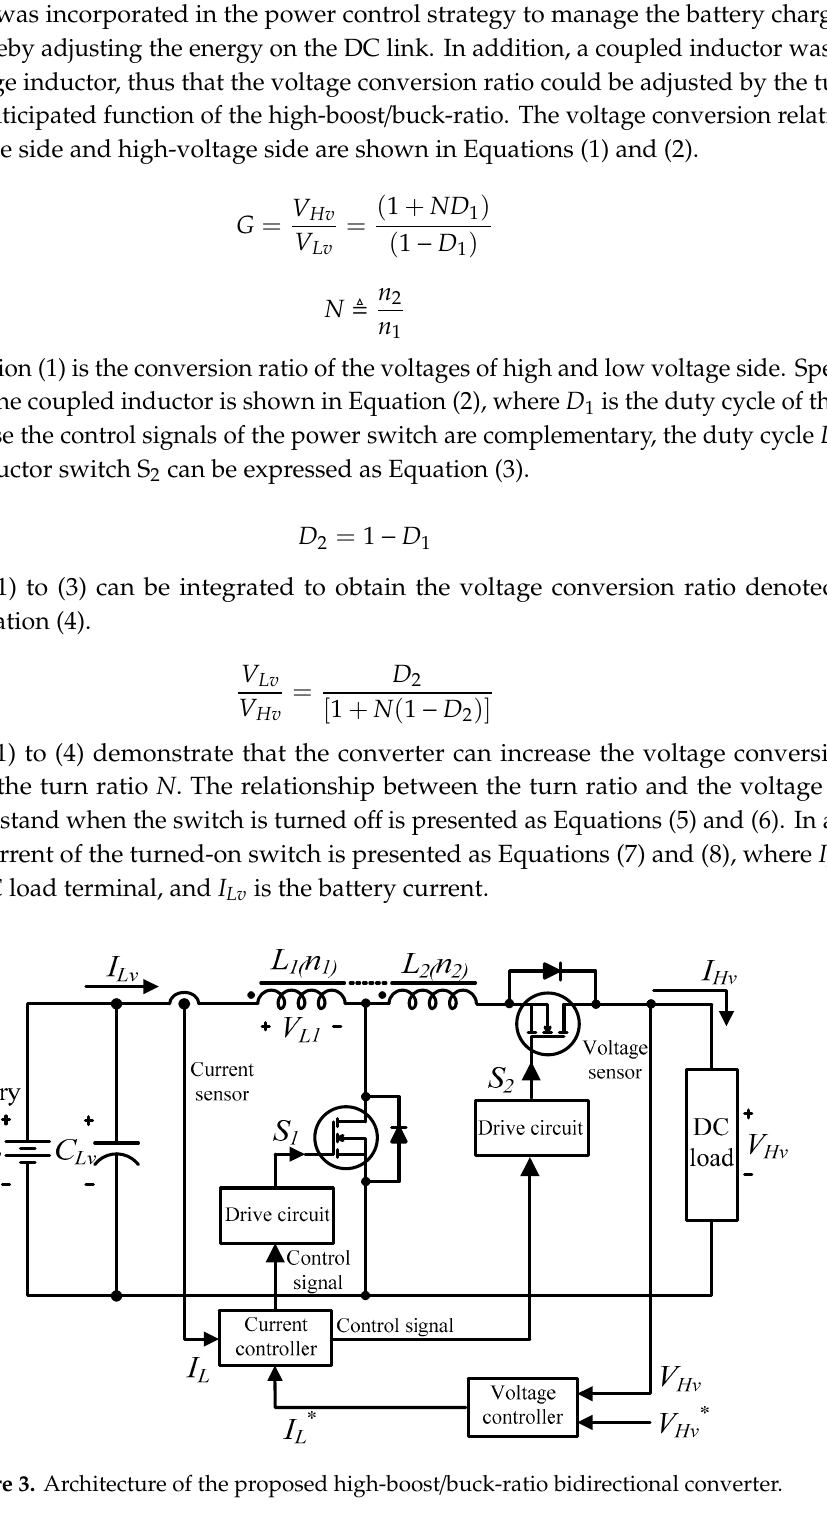
Figure 3. Architecture of the proposed high-boost/buck-ratio bidirectional converter.